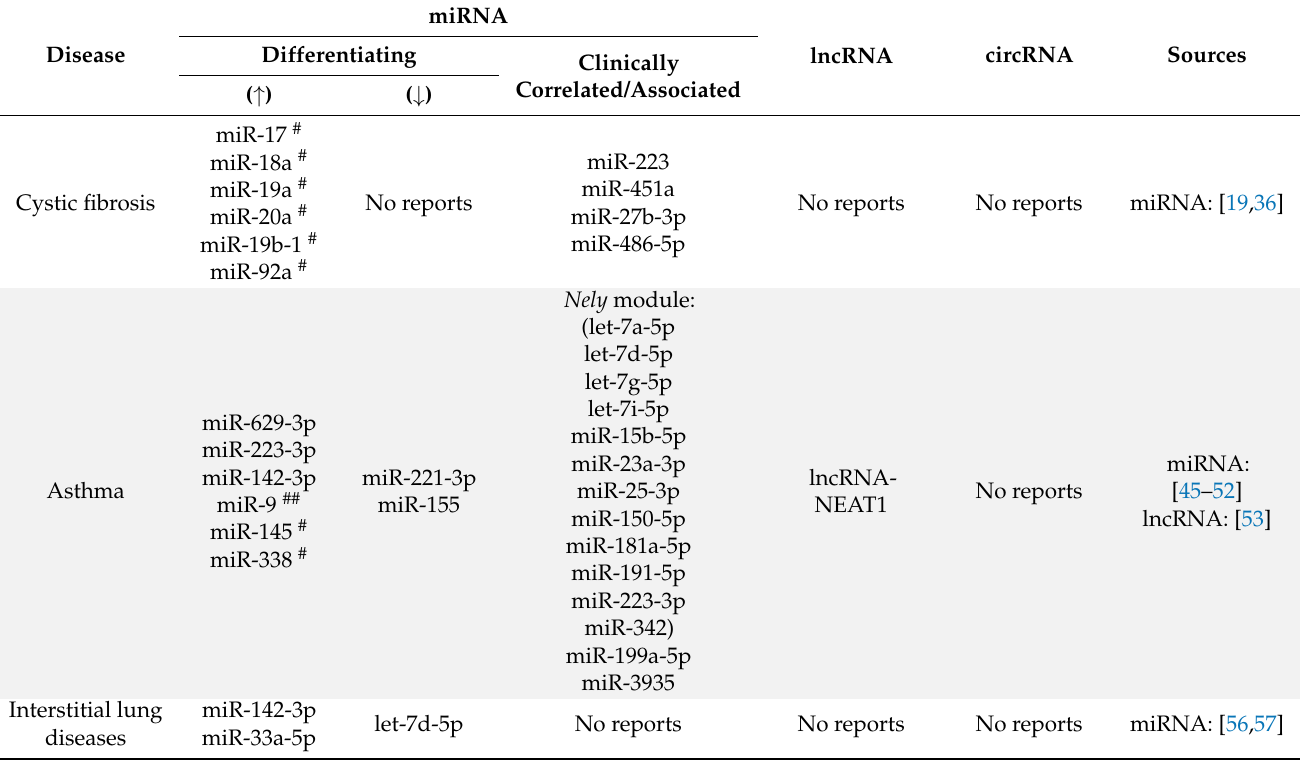
Table 2. Non-coding RNAs investigated in sputum in three examples of respiratory diseases. miRNAs are classified accordingly to their reported nature as disease-differentiating or associated with the clinical